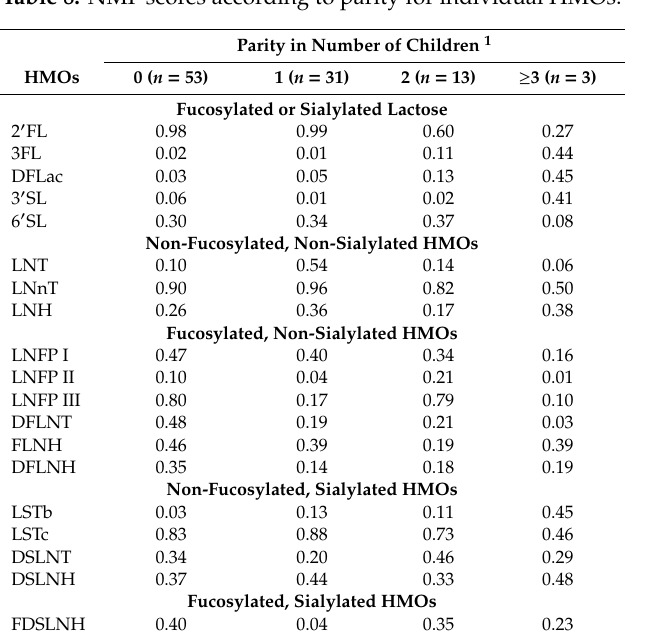
Table 8. NMF scores according to parity for individual